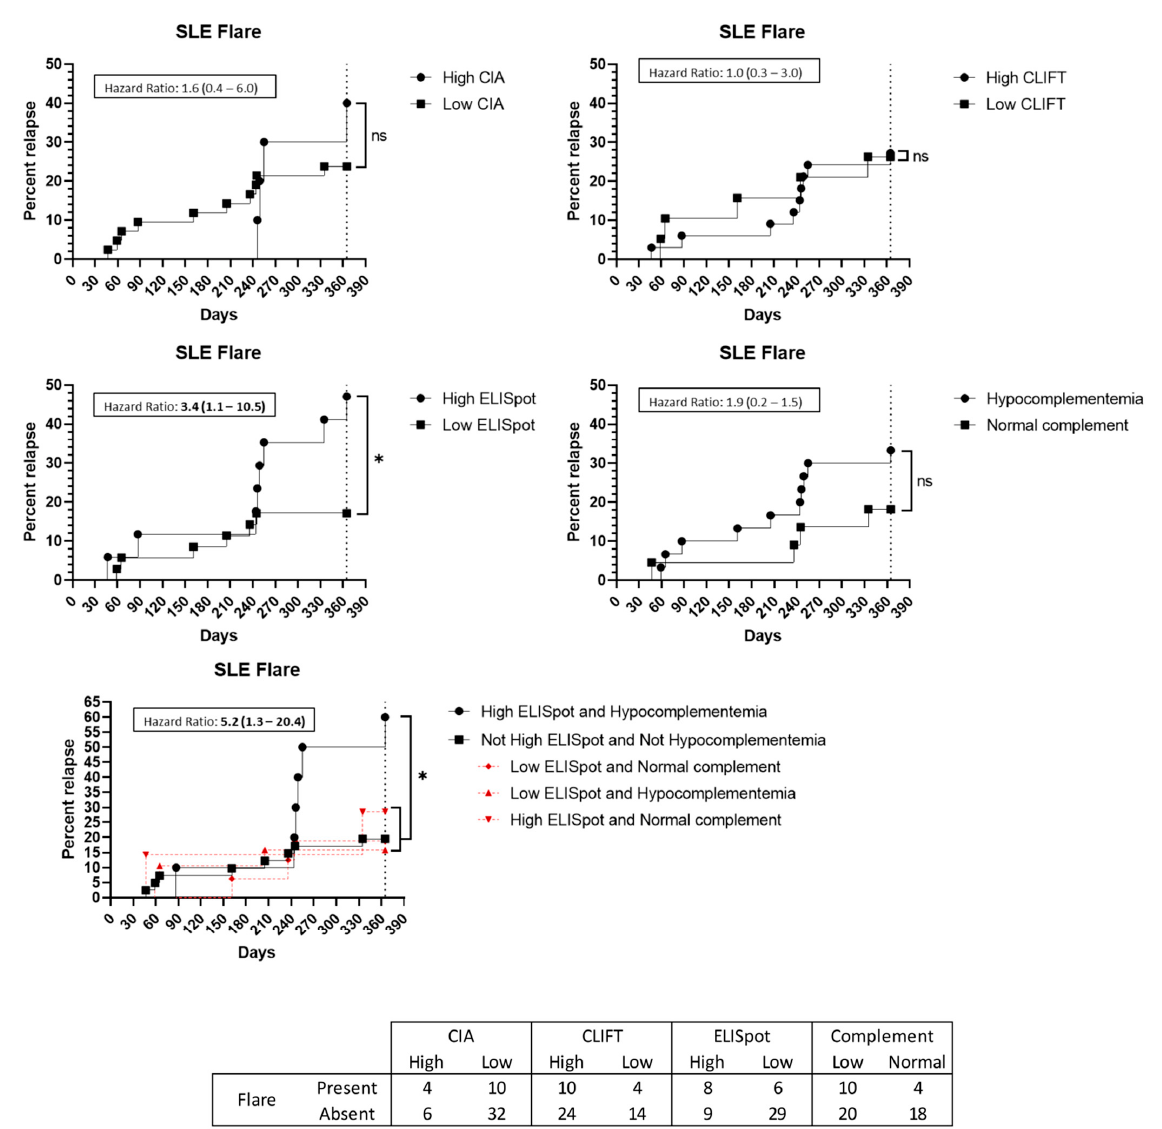
Figure 4. Flare up prediction capacity: Kaplan–Meier survival analysis and hazard ratio. X-axis: days from sampling to flare up. Y-axis: percentage of patients presenting with a flare up. ns: non- significant. *: p < 0.05. Abbreviations: CIA: chemiluminescence immunoassay; CLIFT: Crithidia luciliae indirect immunofluorescence test; SLE: systemic lupus